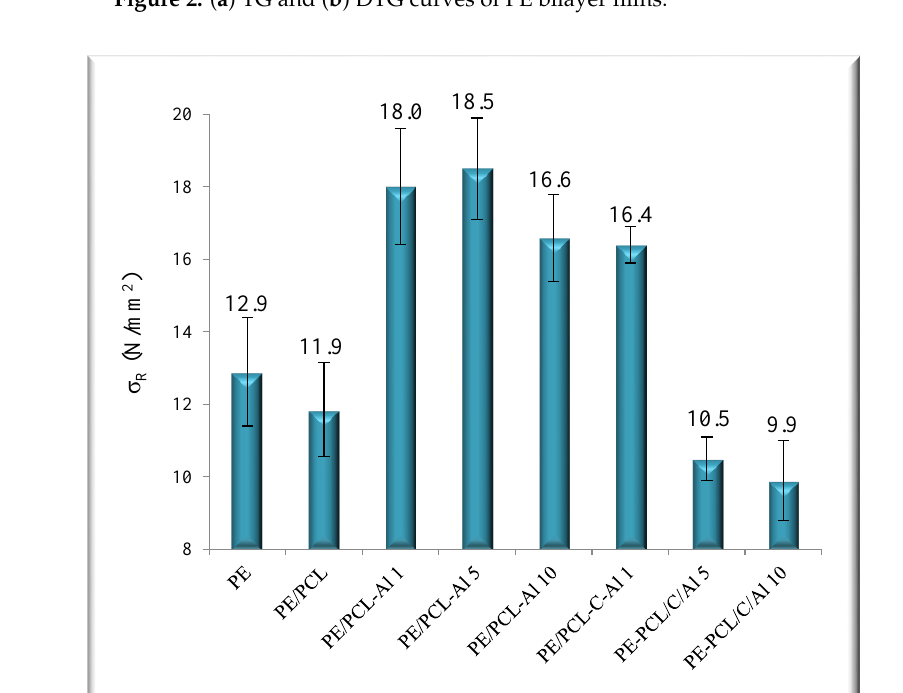
Figure 3. Tensile strength ( σ ) of PE/PCL bilayer